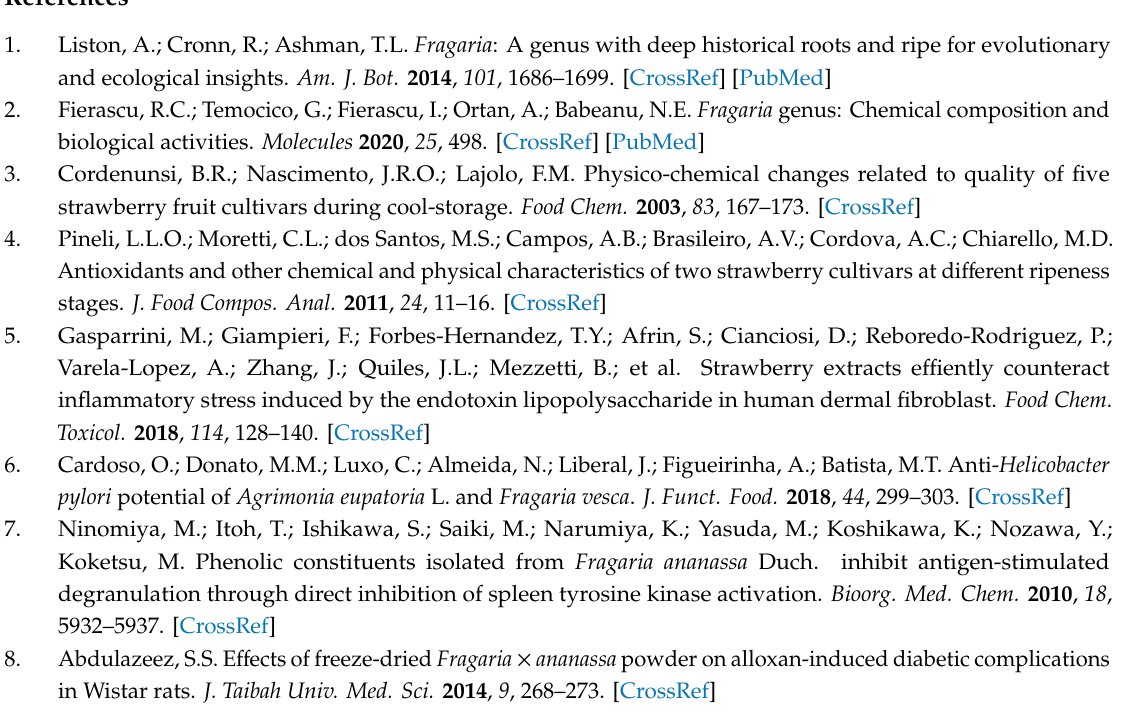
Figure S1: High-performance liquid chromatography with diode array detection chromatogram of free sugars in F. viridis ripe fruits, Figure S2: High-performance liquid chromatography with electrospray ionization triple quadrupole mass spectrometric detection chromatogram of F. viridis ripe fruits extract coupled with spectrophotometric DPPH radical scavenging assay, Table S1: Reference standards used for the qualitative and quantitative analysis by HPLC-DAD-ESI-tQ-MS assays, Table S2: Regression equations, correlation coe ffi cients, standard deviation, limits of detection, limits of quantification, and linear ranges for 48 reference